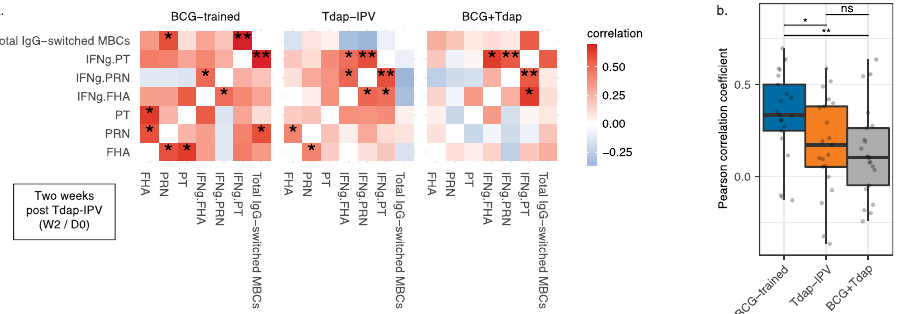
Fig. 3 Pertussis-speci fi c antibody, IFNg, and total memory B cell responses are highly intercorrelated in the BCG-trained cohort following Tdap-IPV vaccination. a Pearson correlation heatmap of increases in pertussis toxin (PT), pertactin (PRN), fi lamentous haemagglutinin (FHA) IgG, IFNg production following peripheral blood mononuclear cell stimulation with pertussis antigens (IFNg.PT, IFNg.PRN, IFNg.FHA), and total IgG-switched memory B cells (MBCs) 2 weeks post Tdap-IPV vaccination. The statistical signi fi cance of the correlation is shown, * p < 0.05; ** p < 0.01. b Pearson correlation coef fi cients were extracted from a and plotted per cohort. Data are represented as a box-and-whisker plots, with bounds from 25th to 75th percentile, median line, and whiskers, which extend to the largest or smallest value no further than 1.5 × the inter- quartile range (distance between the fi rst and third quartiles). Data were compared using the Wilcoxon signed-rank test. Data are from N = 16 – 25 subjects per cohort. * p < 0.05; ** p < 0.01; ns not signi fi